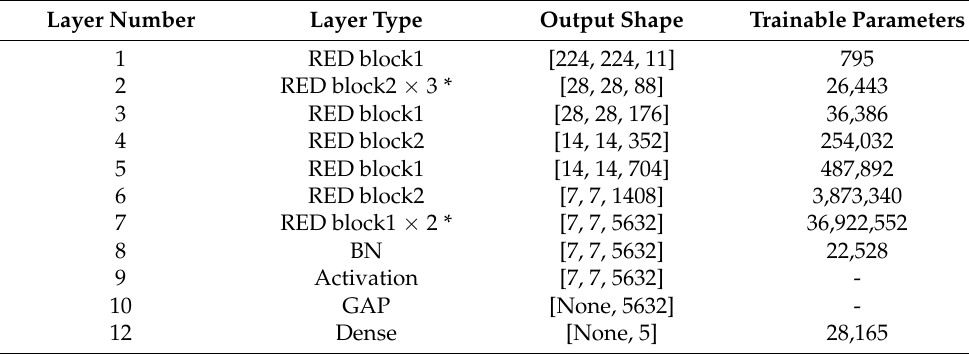
Figure 4. RED-CNN network structure. Table 1. The layers and layer parameters of the proposed model (for the five-classification